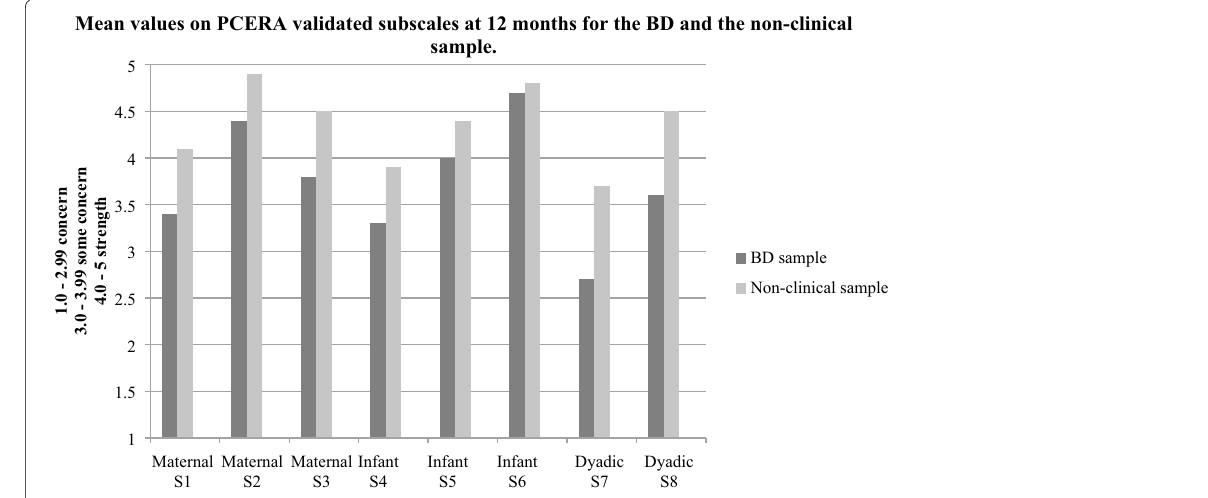
Fig. 1 Mean values on PCERA validated subscales at 12 months for the BD and the non-clinical